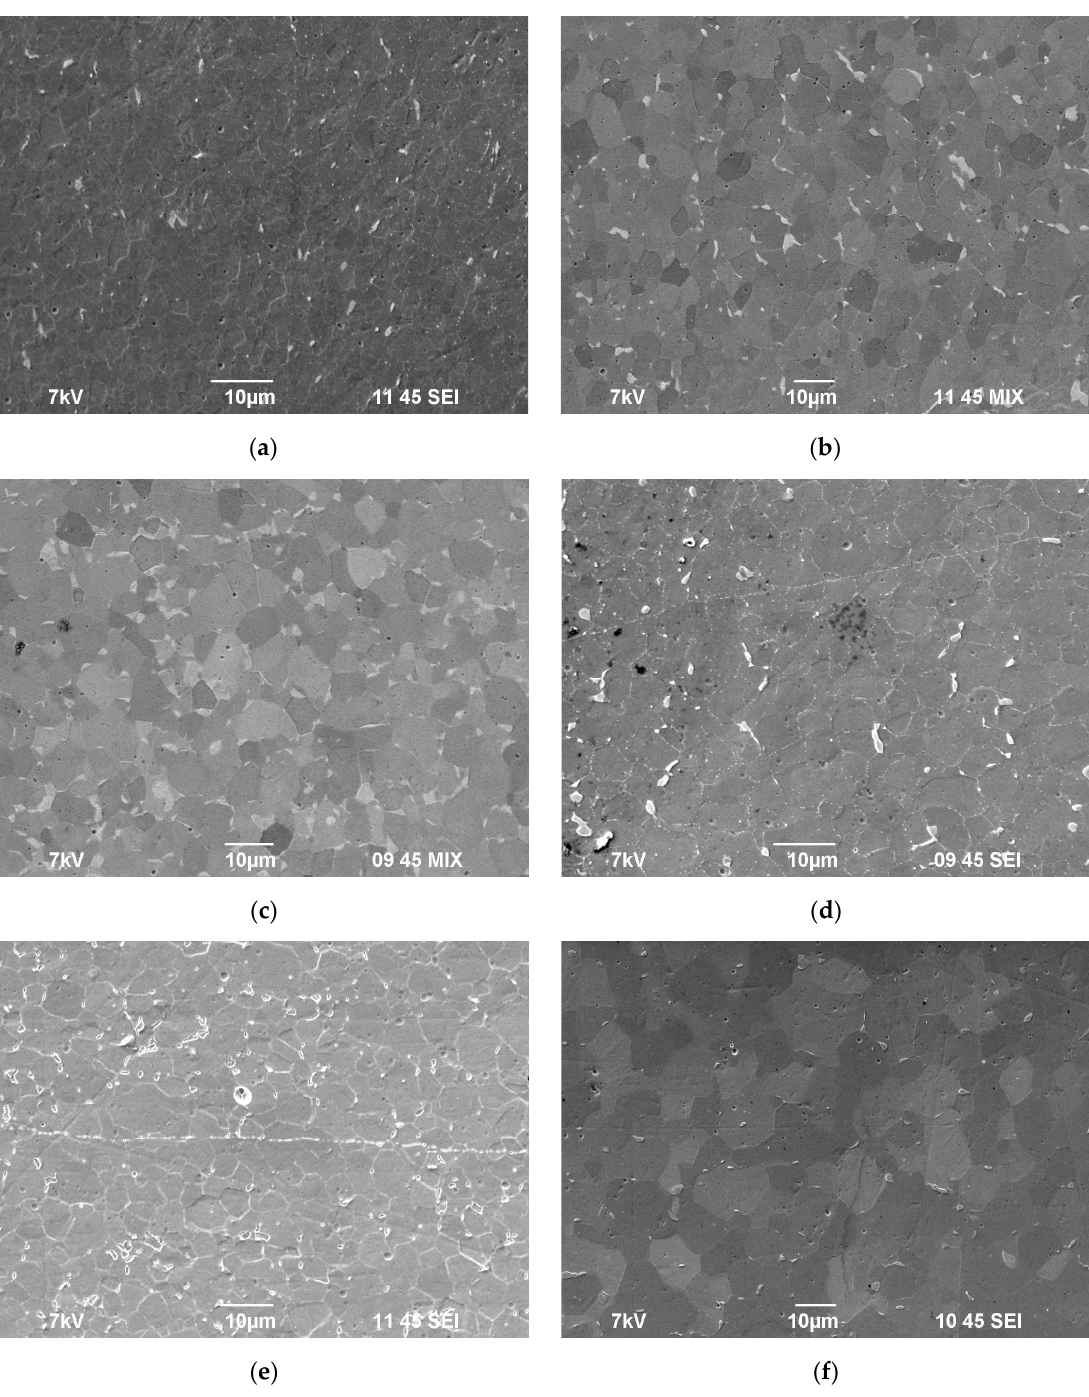
Figure 9. Microstructure of the UFG specimens obtained in di ff erent di ff usion welding regimes (P = 50 MPa): ( a ) V h = 50 °C/min, T = 600 °C, t = 10 min; ( b ) V h = 50 °C/min, T = 700 °C, t = 10 min; ( c ) V h = 50 °C/min, T = 800 °C, t = 10 min; ( d ) V h = 100 °C/min, T = 700 °C, t = 10 min; ( e ) V h = 350 °C/min, T = 700 °C, t = 10 min; ( f ) V h = 50 °C/min, T = 700 °C, t = 90 min. SEM.